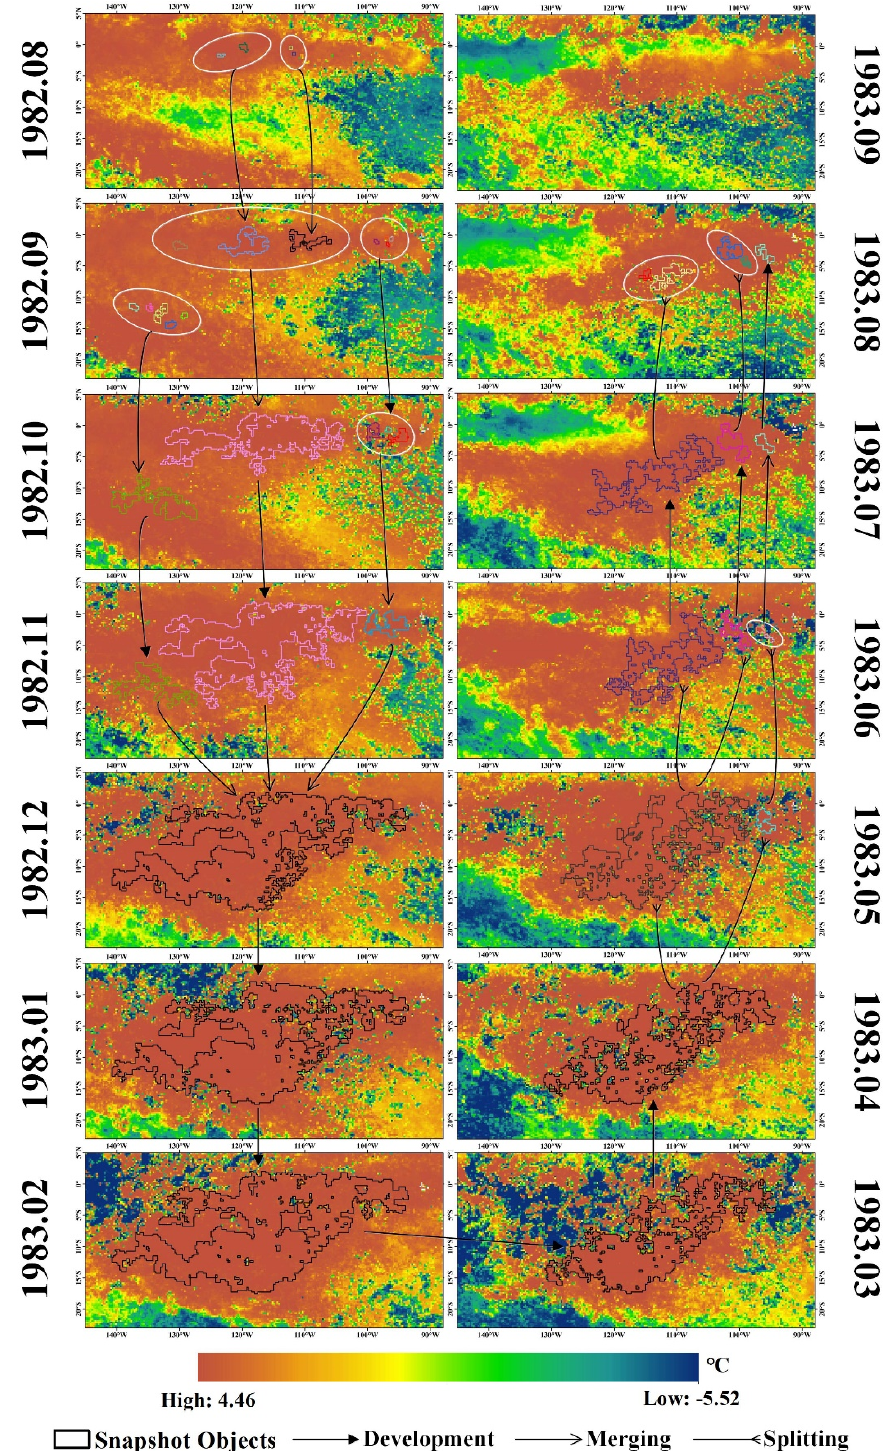
Figure 13. An evolution of the process objects of SSTA during the period from 1982 to 1983 in the Pacific Ocean. The snapshot objects contained in the white circle are divided into two situations: (1) merging at the next moment and (2) splitting from the previous moment.